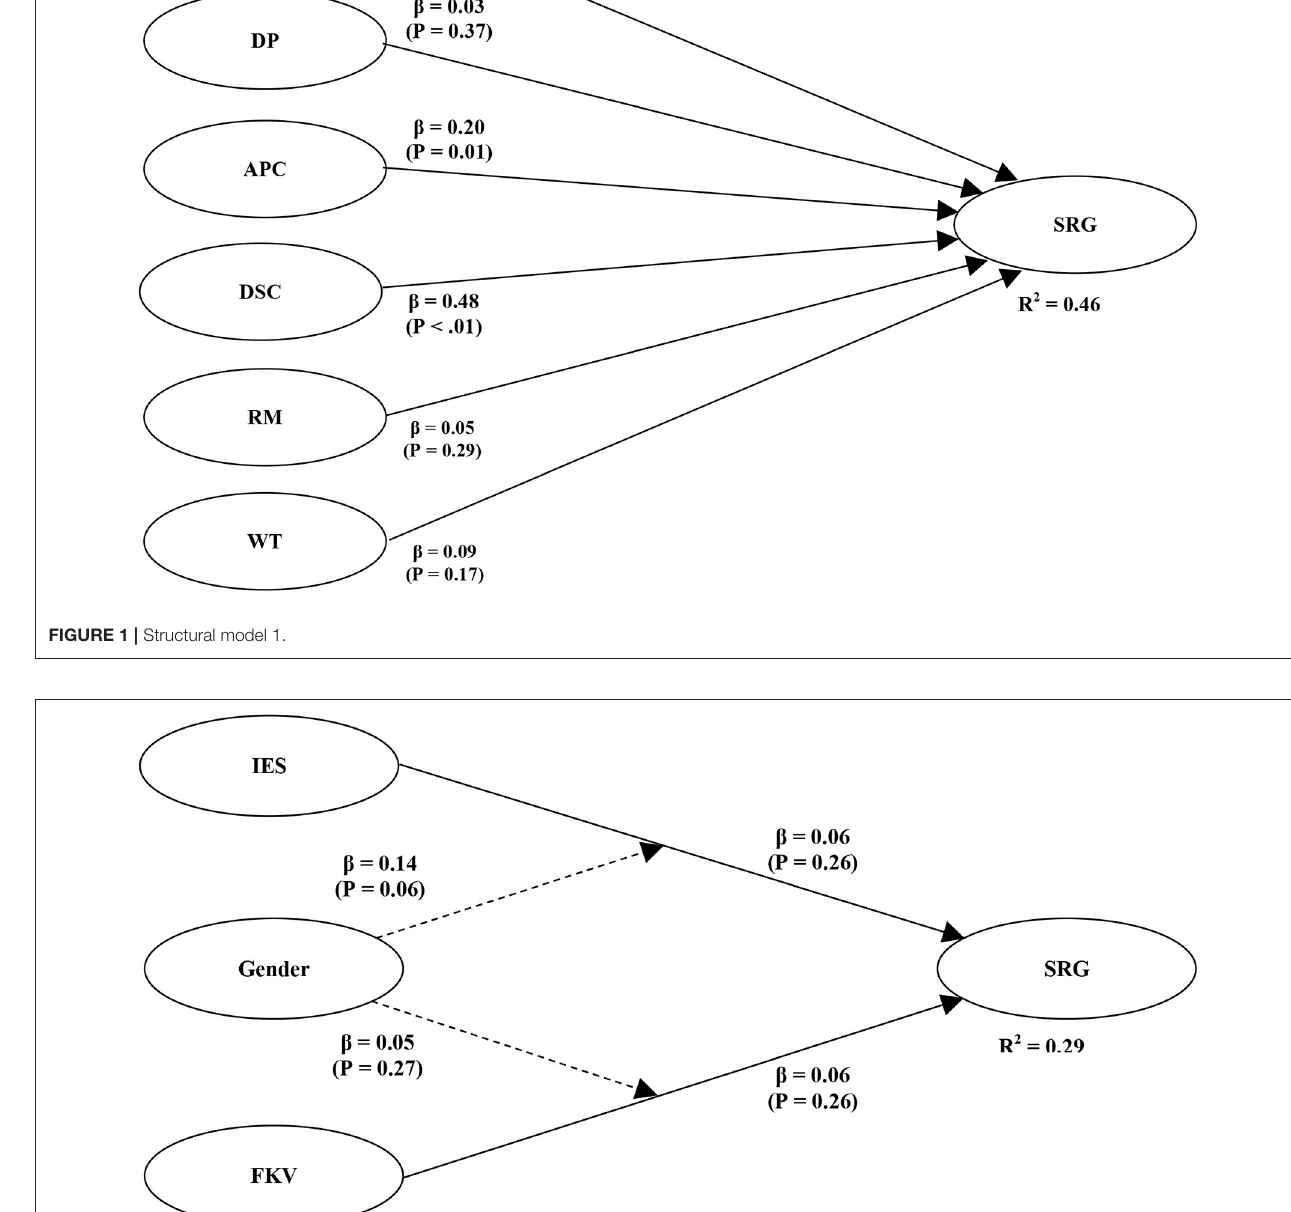
FIGURE 2 | Structural model